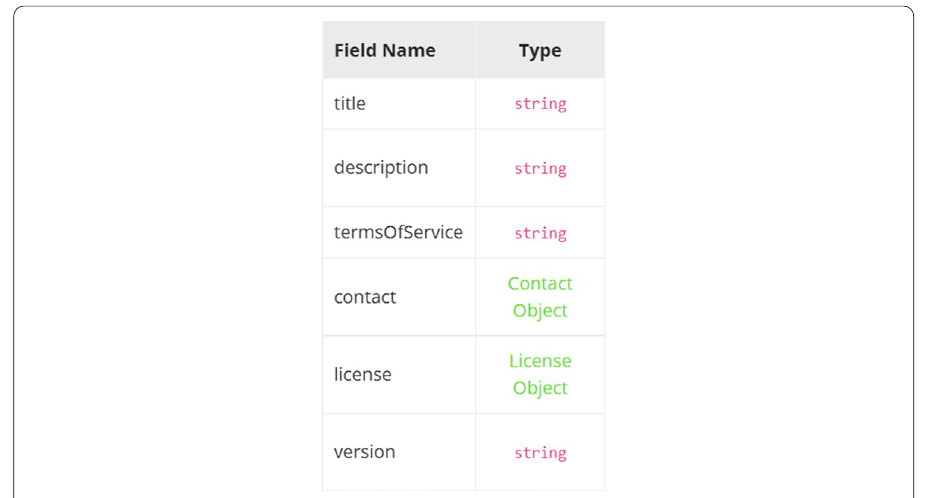
Fig. 4 Structure of the info section on the OAS